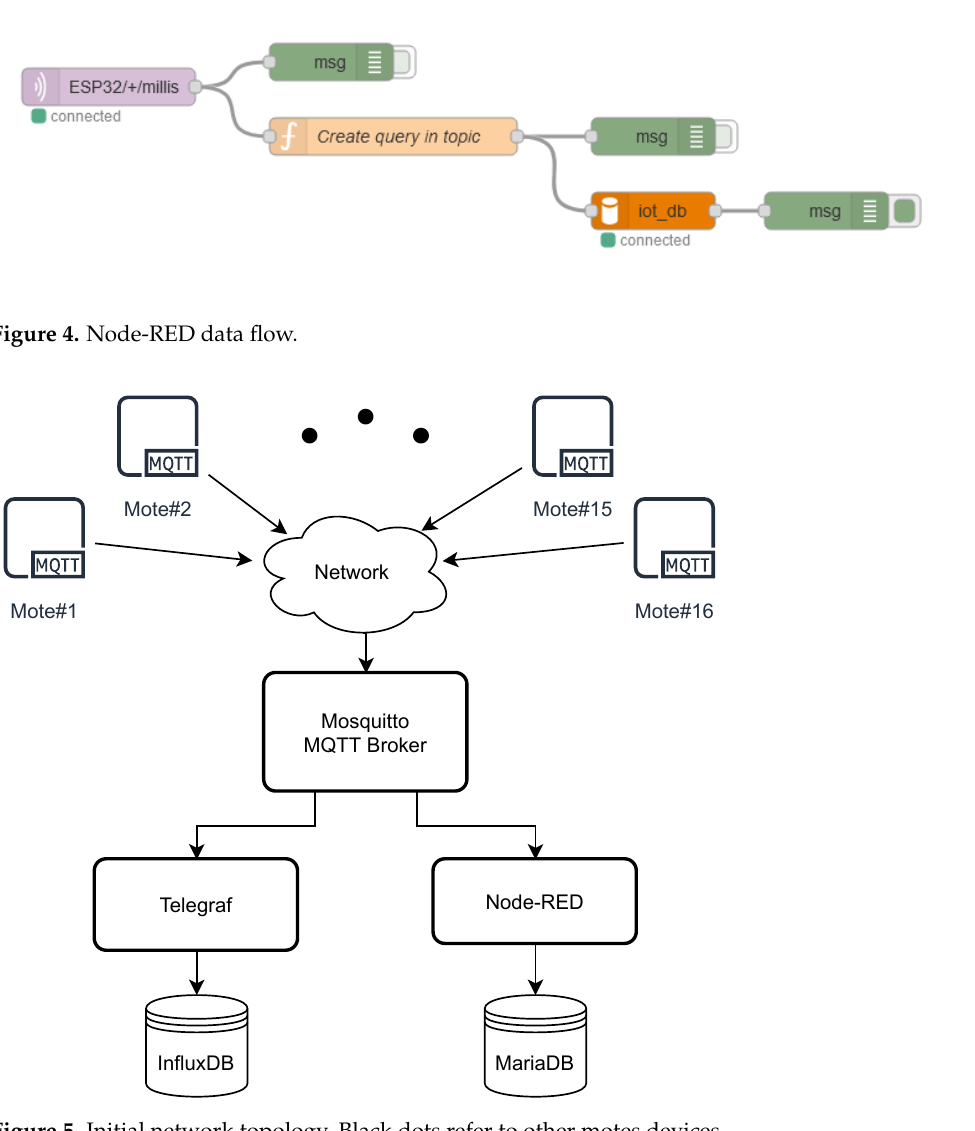
Figure 5. Initial network topology. Black dots refer to other motes